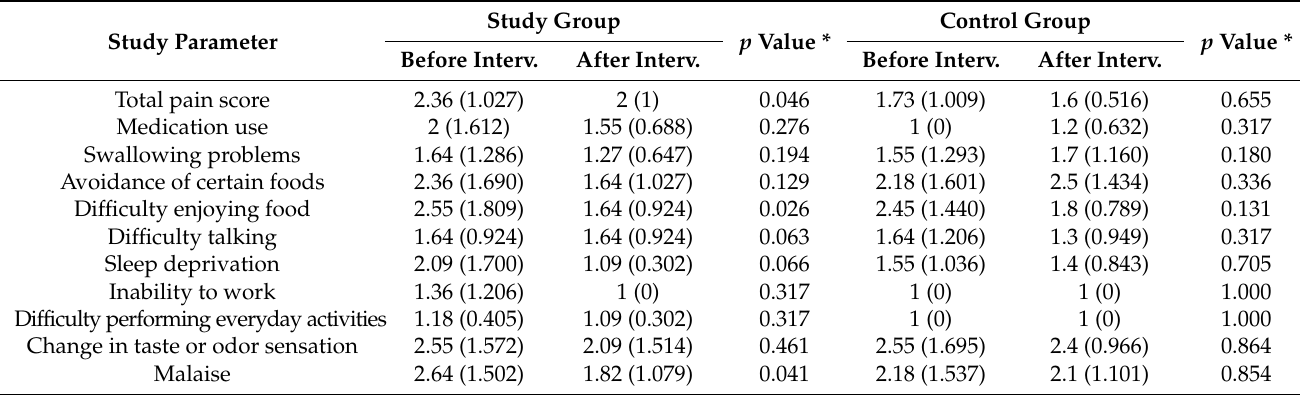
Table 1. Change in study parameters in patients with BMS who attended a support group (study group) and patients who did not (control